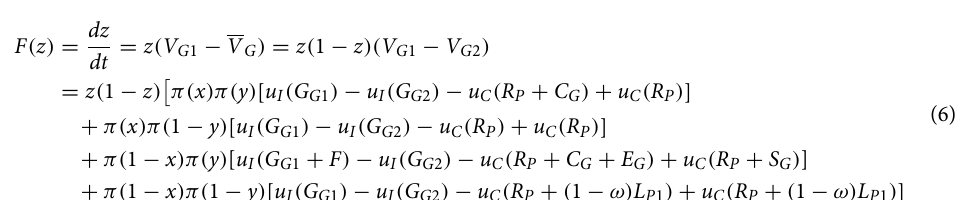
Figure 9. Replicated dynamic phase diagram of private